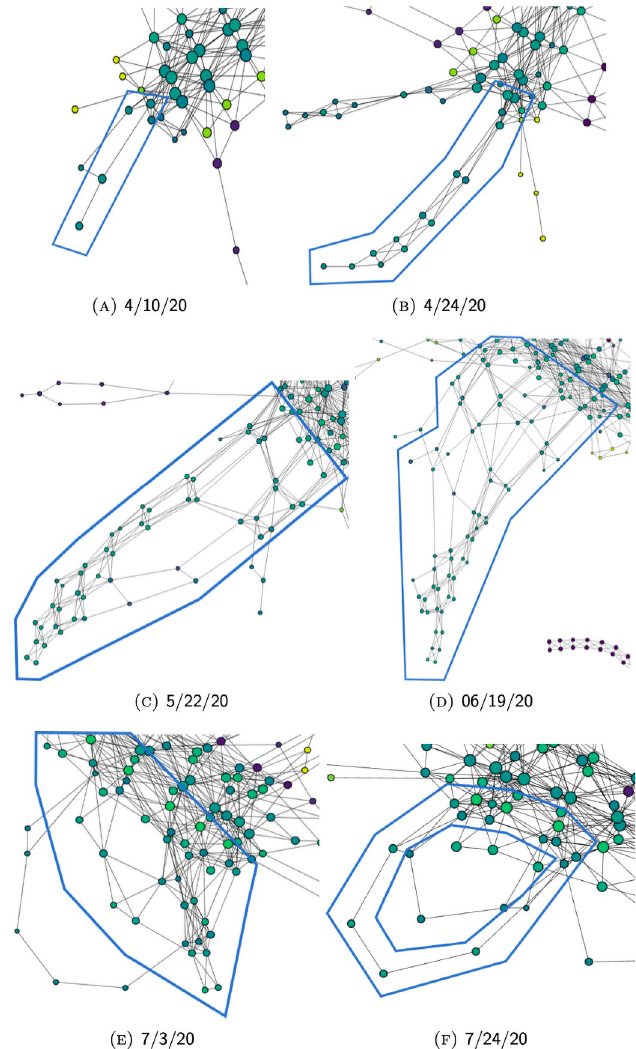
Fig 14. The evolution of the Massachusetts-New Jersey complex over time. (Using filtered data which allows the features of areas away from New York, LA County, and Cook County to be more pronounced.).